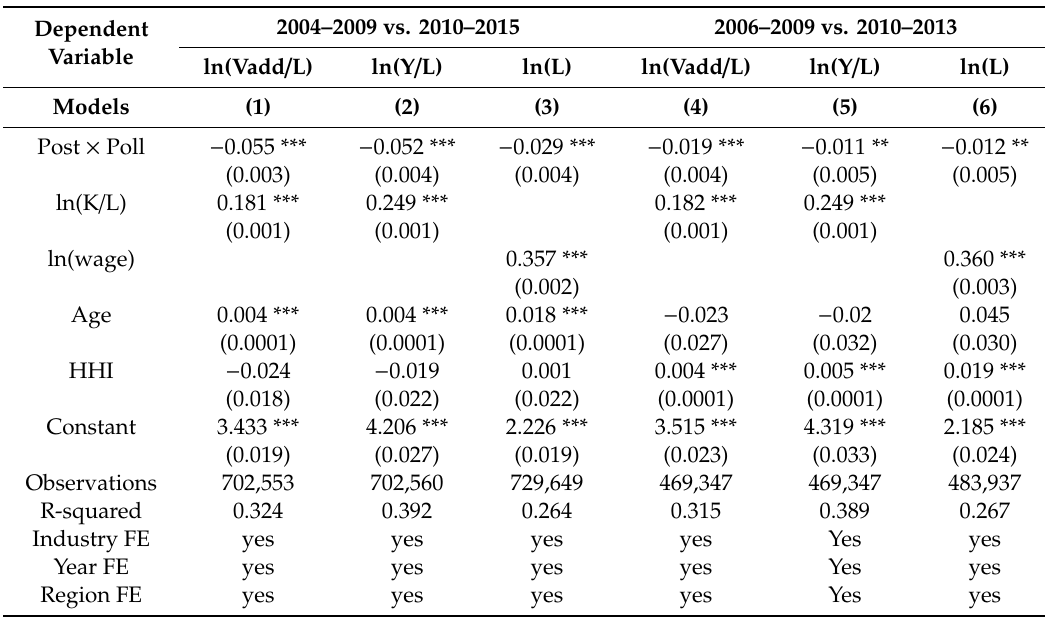
Table 2. Estimation results based on labor productivity and employment as dependent variables for polluting